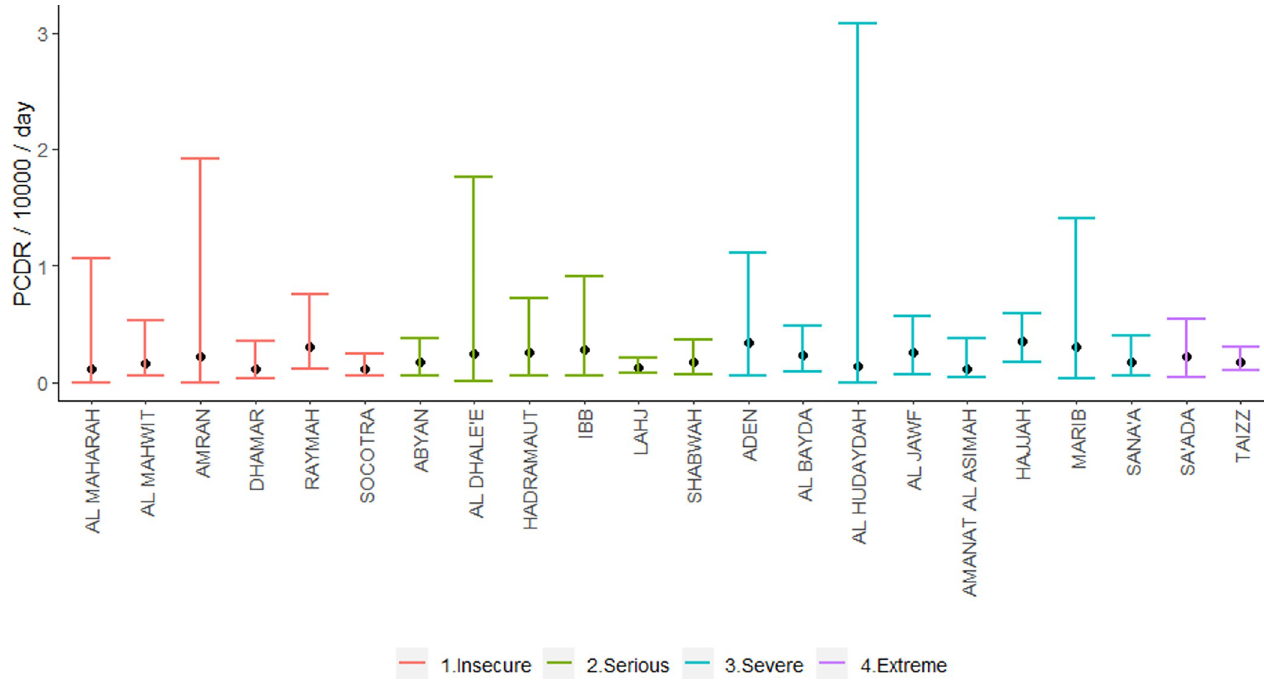
Fig 5. Humanitarian aid assistance to Yemen 2012–2019. Data source: United Nations Office for the Coordination of Humanitarian Aid (UN-OCHA) [52].